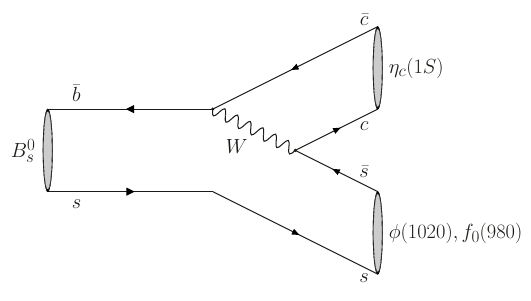
Figure 1 . Leading diagram corresponding to B 0 (cid:25) + (cid:25) (cid:0) pair may arise from the decay of the f 0 (980) resonance.